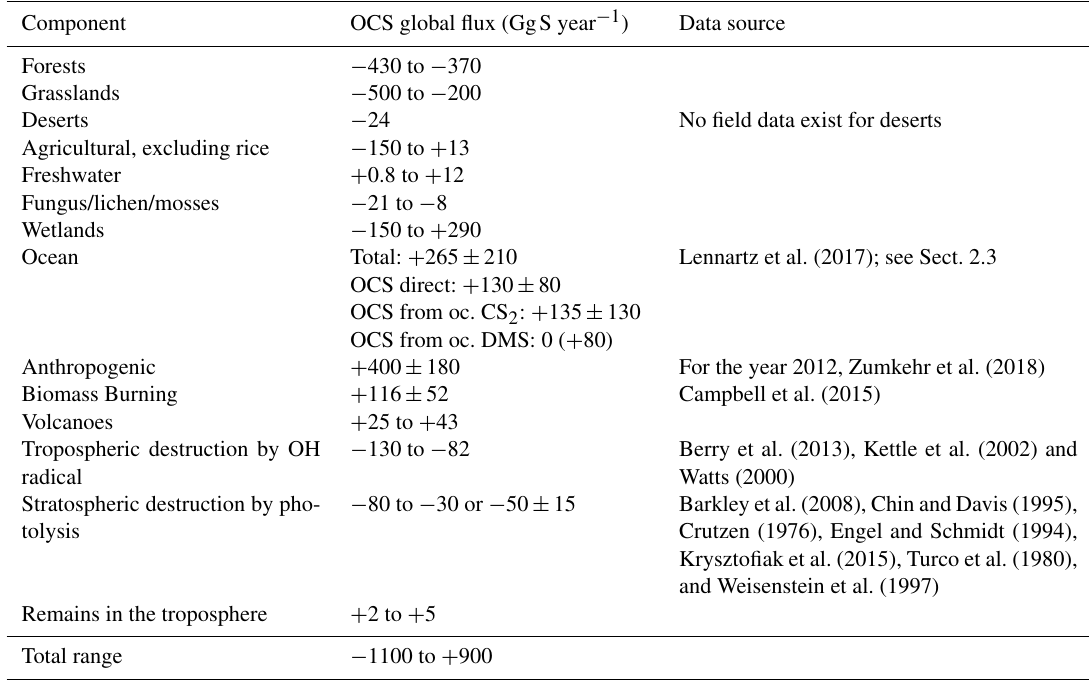
Table 4. Total bottom-up atmospheric OCS budget.